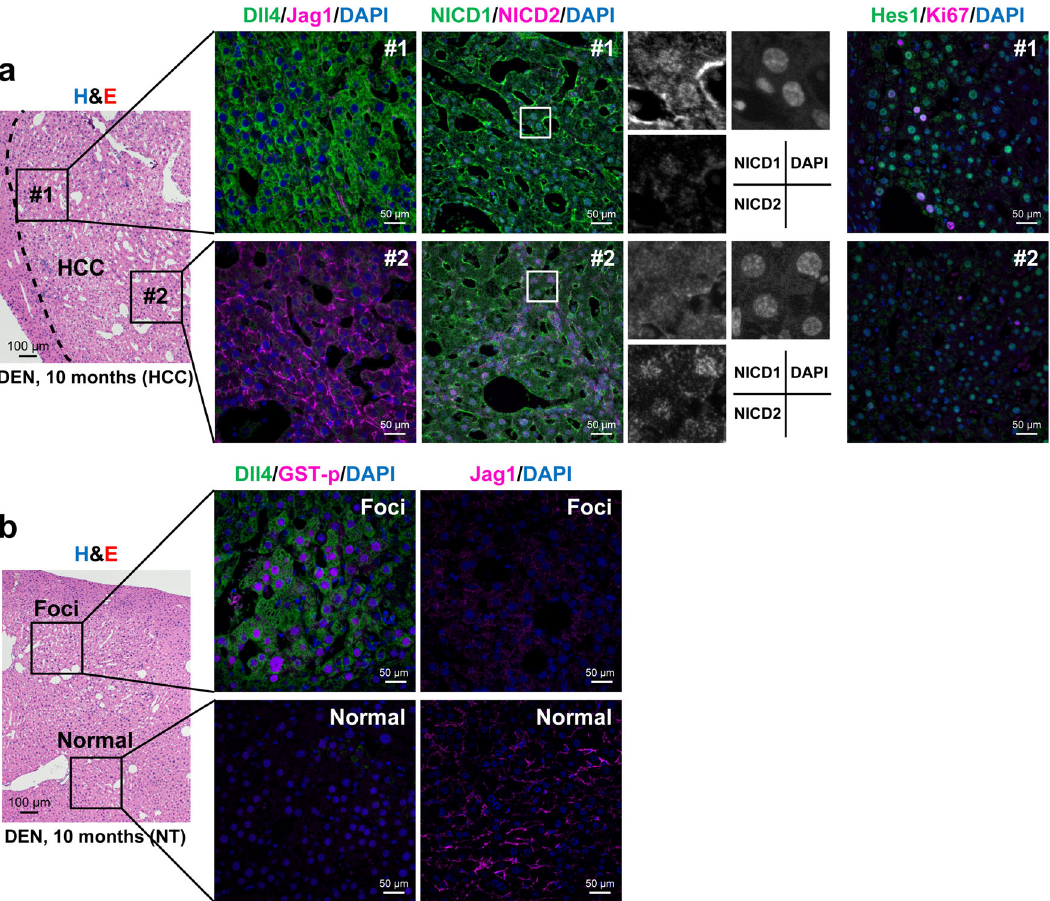
Fig. 2 Expression levels of the Notch ligand and receptor proteins in DEN-induced HCC tissues and glutathione S-transferase placental type (GST-p)- positive preneoplastic foci. Sections prepared from HCC tissues ( a ) and preneoplastic foci ( b ) were subjected to hematoxylin and eosin (H&E) staining and immuno fl uorescent co-staining with antibodies against Dll4, Jag1, Notch1 intracellular domain (NICD1), Notch2 intracellular domain (NICD2), Hes1, Ki67 (a cell proliferation marker molecule), or GST-p together with DAPI nuclear staining. Two representative areas are shown that represent the peripheral ( #1 ) and intrinsic ( #2 ) regions within the HCC tissues. Normal liver tissues (NT) were also analyzed as controls. Scale bars, 100 μ m in H&E staining and 50 μ m in immuno fl uorescent